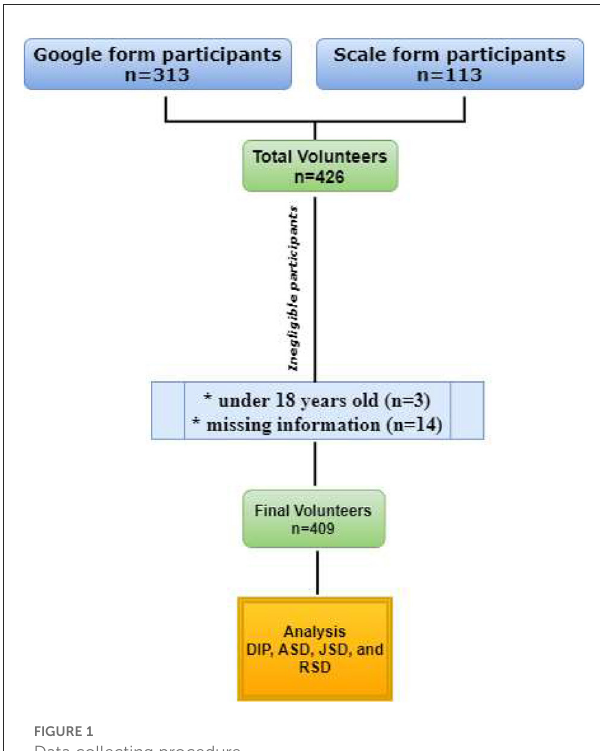
FIGURE1 Data collecting procedure.